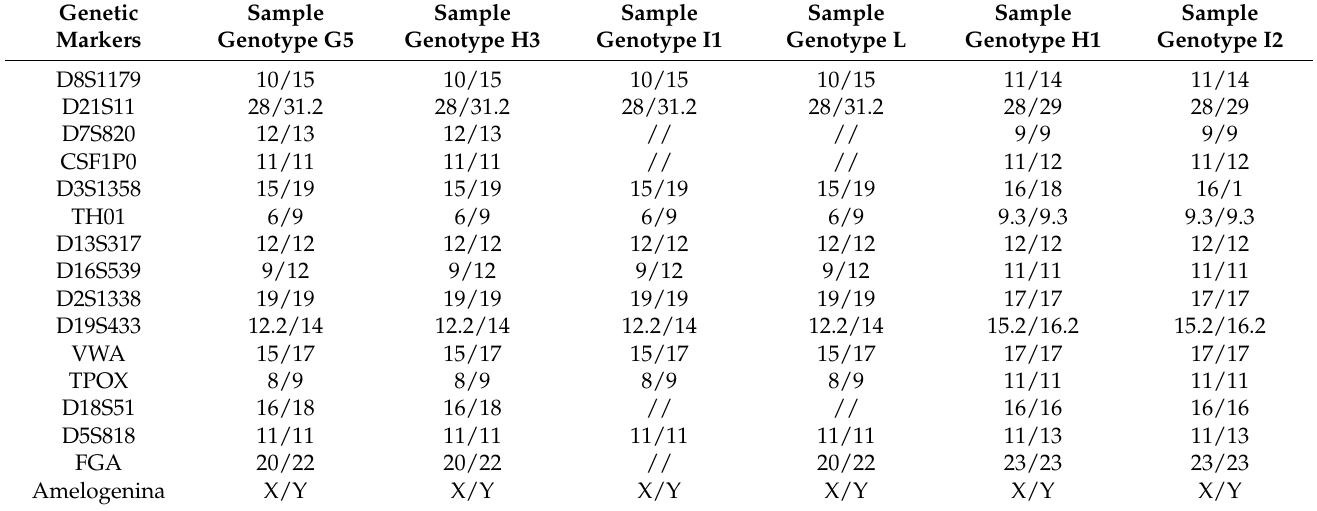
Table 4. Autosomal DNA chromosome polymorphisms